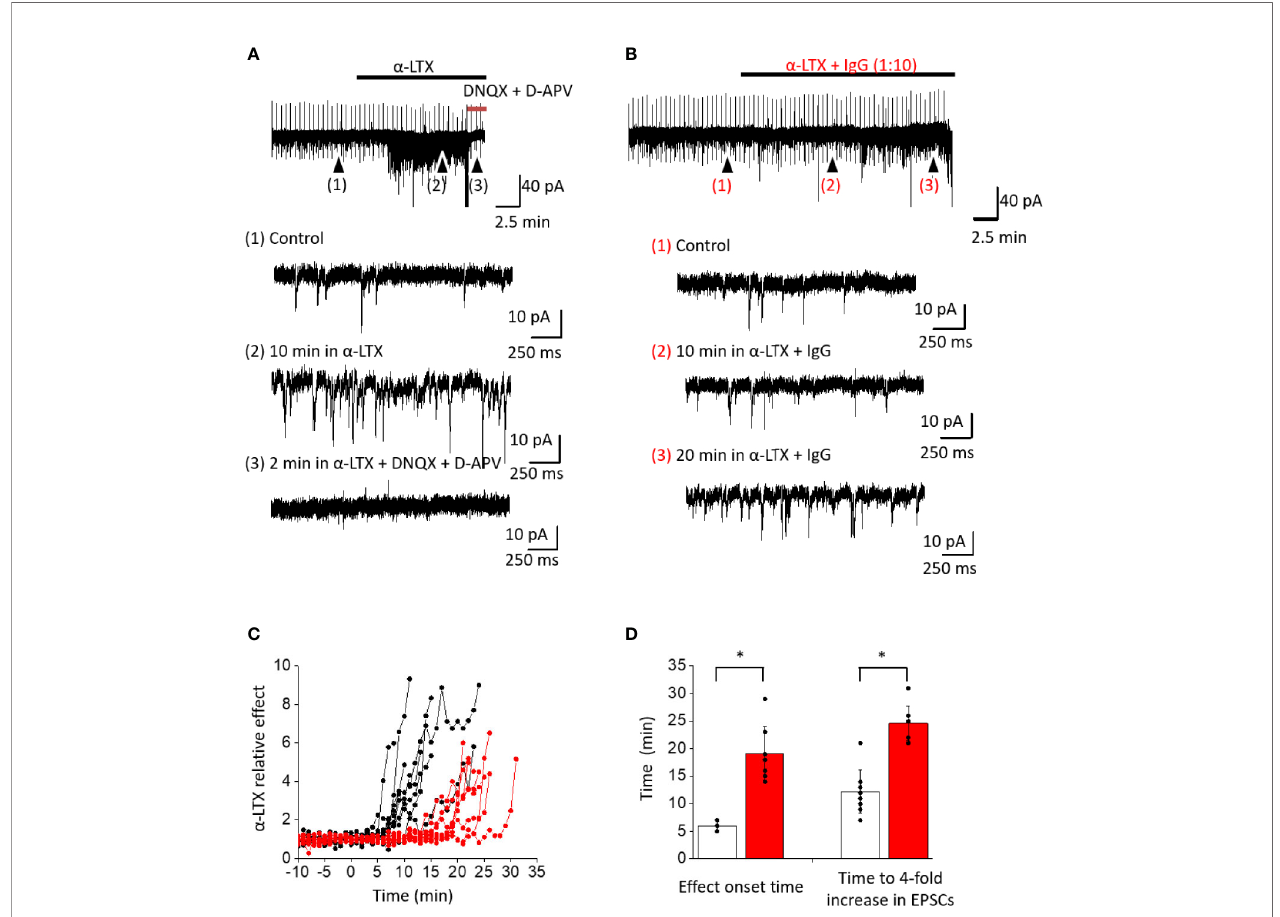
FIGURE 5 | Effect of a -LTX and its mixture with IgG TPL0020_02_G9 at 1:10 ratio (w/w) on spontaneous EPSC frequency in pyramidal neurons from mPFC. (A) Representative recording of a -LTX action. Time course of the experiment and expanded parts in control (1), after 10 min of a -LTX application (2), and after 10 m M DNQX and 100 m M D-APV application (3) are shown. a -LTX causes a strong increase of spontaneous EPSC frequency, and selective antagonists of ionotropic glutamate receptors abolish this effect. (B) Representative recording of a -LTX action in the presence of IgG TPL0020_02_G9. Strong frequency increase is seen only after 20 min of application. (C) Time development of a -LTX effect and its modulation by IgG. Spontaneous EPSC frequencies are normalized to the average control values. The development of effect is strongly delayed in the presence of IgG (red traces) compared to control with a -LTX alone (black traces). (D) Characteristic times when the 3 × SD threshold is reached or spontaneous EPSC frequency is increased four-fold for a -LTX alone (white bars) and in the presence of the IgG (red bars). The differences are signi fi cant (p < 0.05, unpaired